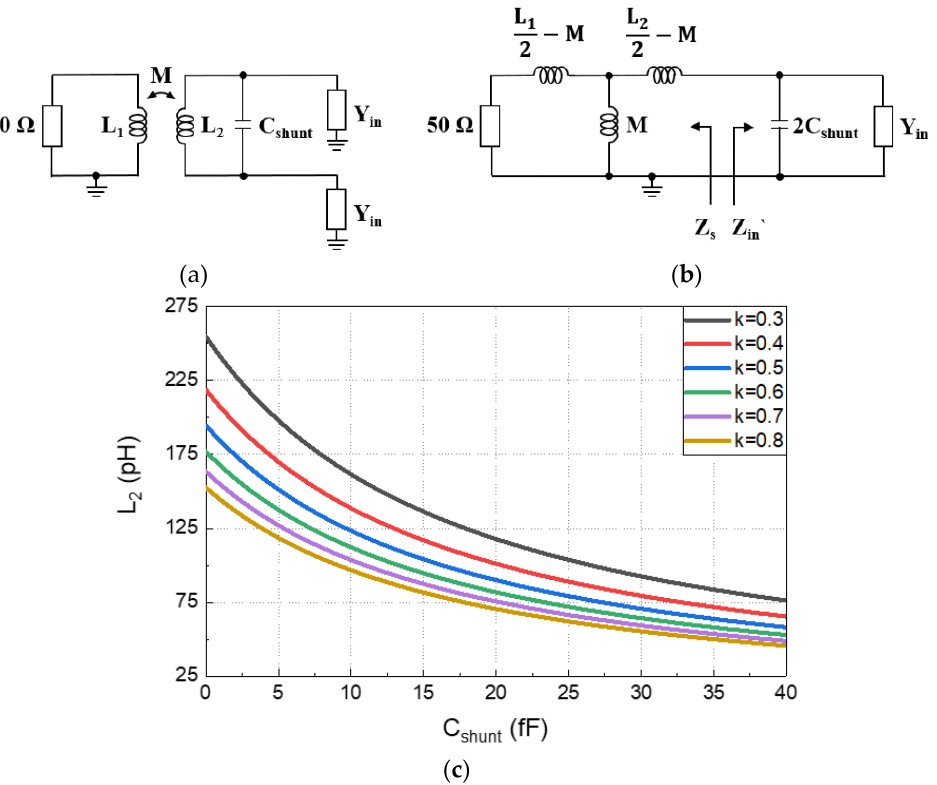
Figure 7. ( a ) A transformer-based impedance matching network. ( b ) A simple equivalent circuit of the matching network is presented by a half circuit for easy analysis. ( c ) The calculated secondary inductance according to coupling coefficient against C shunt at 73 GHz.